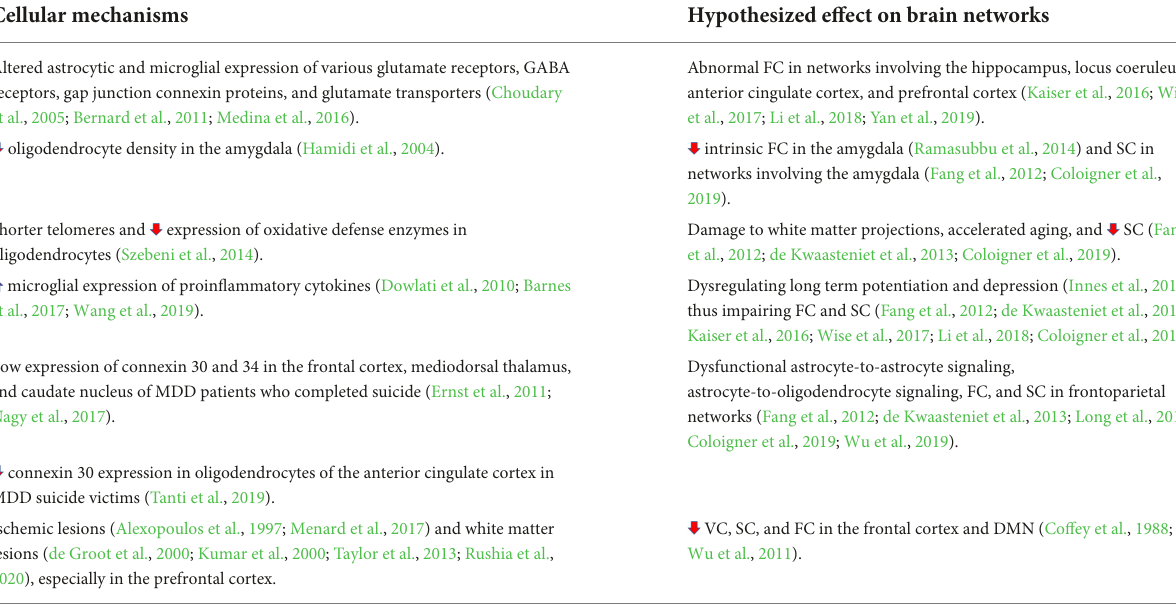
TABLE 3 Summary of the cellular mechanisms found in major depressive disorder and their suggested effect on the brain. Major depressive disorder (MDD) Cellular